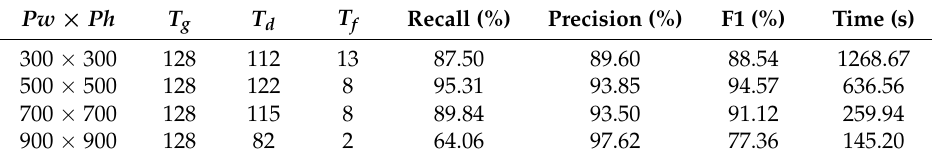
Table 15. Results on the large-scale SAR image in terms of patch size. Pw ×